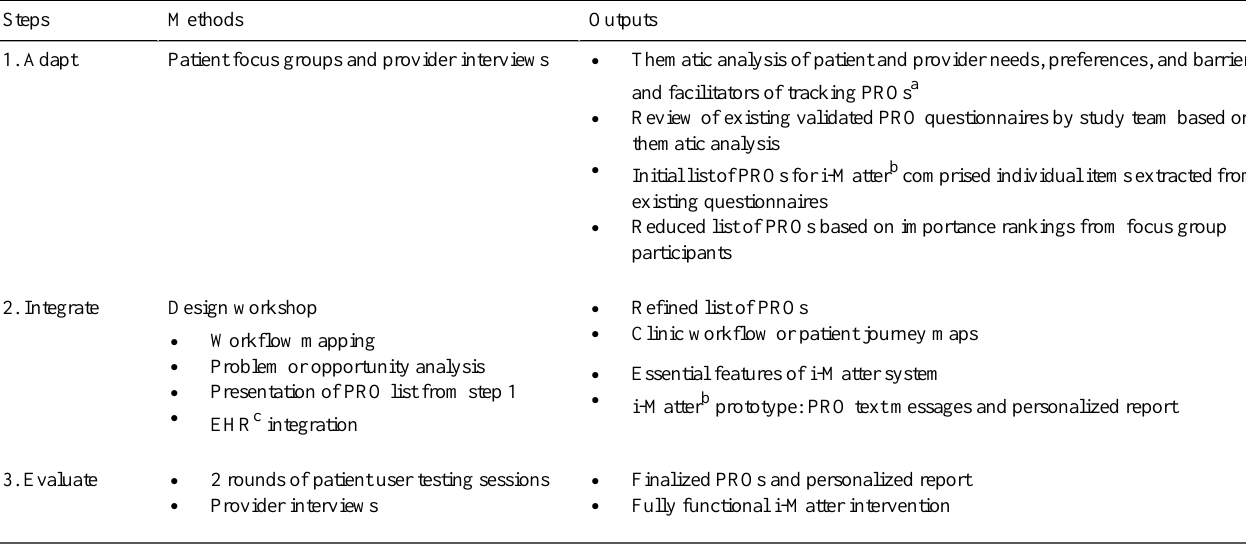
Table 2. Evidence-based user-centered design process for the development of patient-reported outcome text